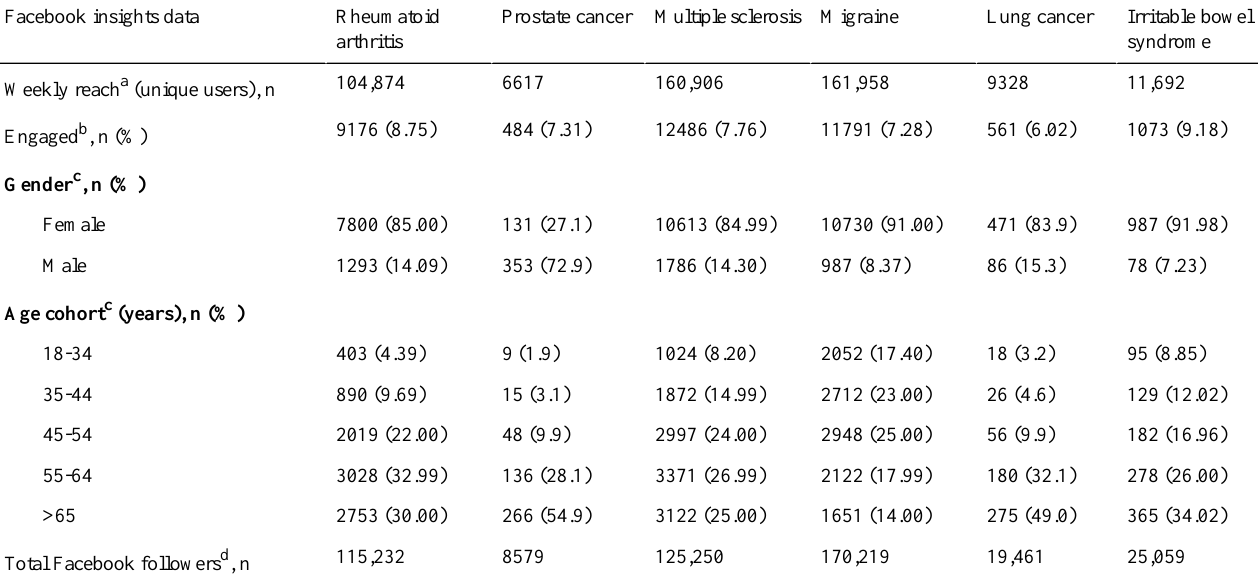
Table 1. Average weekly organic reach and engaged users per Facebook community (Facebook insights data from RheumatoidArthritis.net, ProstateCancer.net, MultipleSclerosis.net, Migraine.com, LungCancer.net, IrritableBowelSyndrome.net Pages, January 1 to June 30,